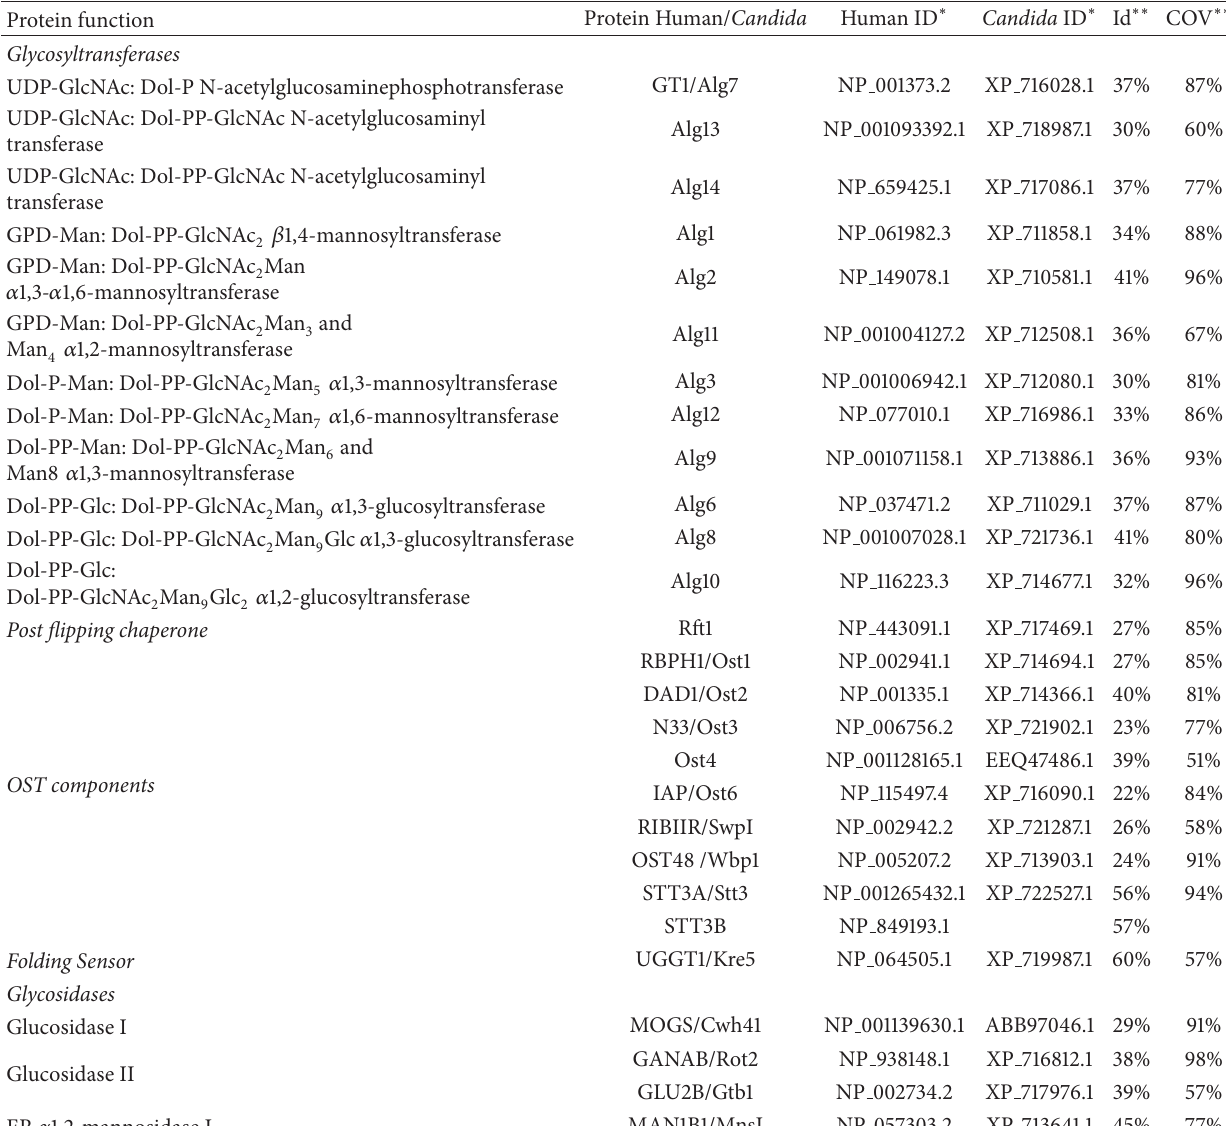
Table 1: Human and C. albicans homolog proteins involved in the N -linked glycosylation pathway. Protein